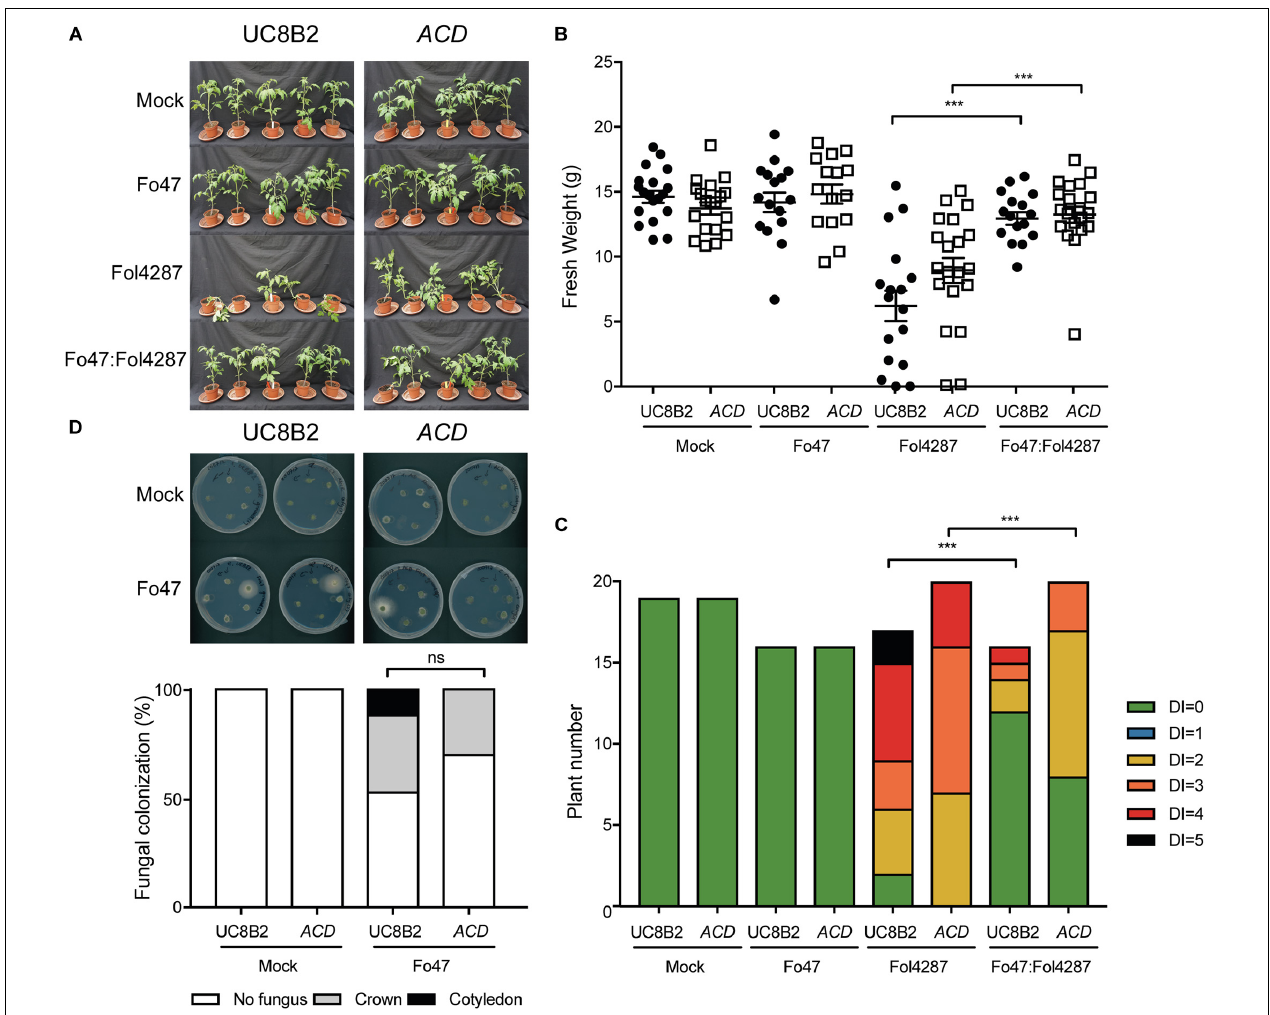
FIGURE 5 | Impaired ethylene perception in tomato does not affect EMR triggered by Fo47. (A) Ten days old wild-type tomato seedlings (Pearson) and Nr plants impaired in ET perception were inoculated with water (mock), Fo47, Fol4287 or co-inoculated with Fo47 and Fol4287. Disease development was assessed by measuring fresh weight (B) and disease index (C) 3 weeks after inoculation. Raw data was analyzed by a non-parametric Mann–Whitney U -test ( ∗∗∗ P < 0.001). The bioassay was performed twice with similar results [where the number of plants (n) was n = 10 for the first repetition and n = 20 for the second repetition]. (D) Representative stem pieces taken from crown (left) and cotyledon (right) level of five individual plants incubated for 4 days on PDA plates. Percentage of Fo47 colonization on mock-inoculated plants ( n = 10) and Fo47 treated plants ( n = 20). The experiment was performed twice with similar results. Raw data was analyzed by a non-parametric Mann–Whitney U -test ( ∗∗∗ P <